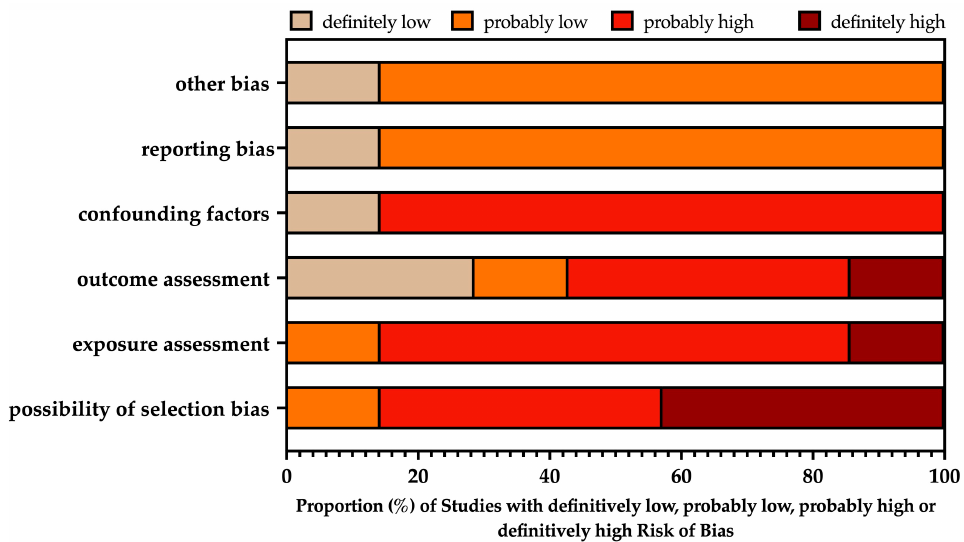
Figure 2. Summary of risk of bias assessment according to the National Toxicology Program (NTP)’s Office of Health Assessment and Translation (OHAT) handbook and respective risk of bias (ROB) tool